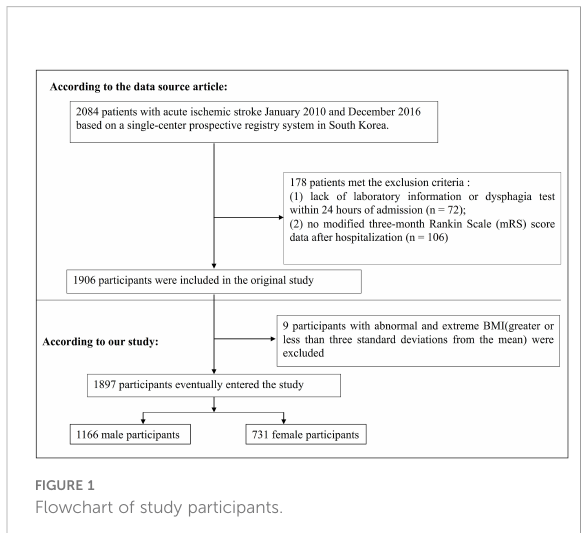
FIGURE 1 Flowchart of study